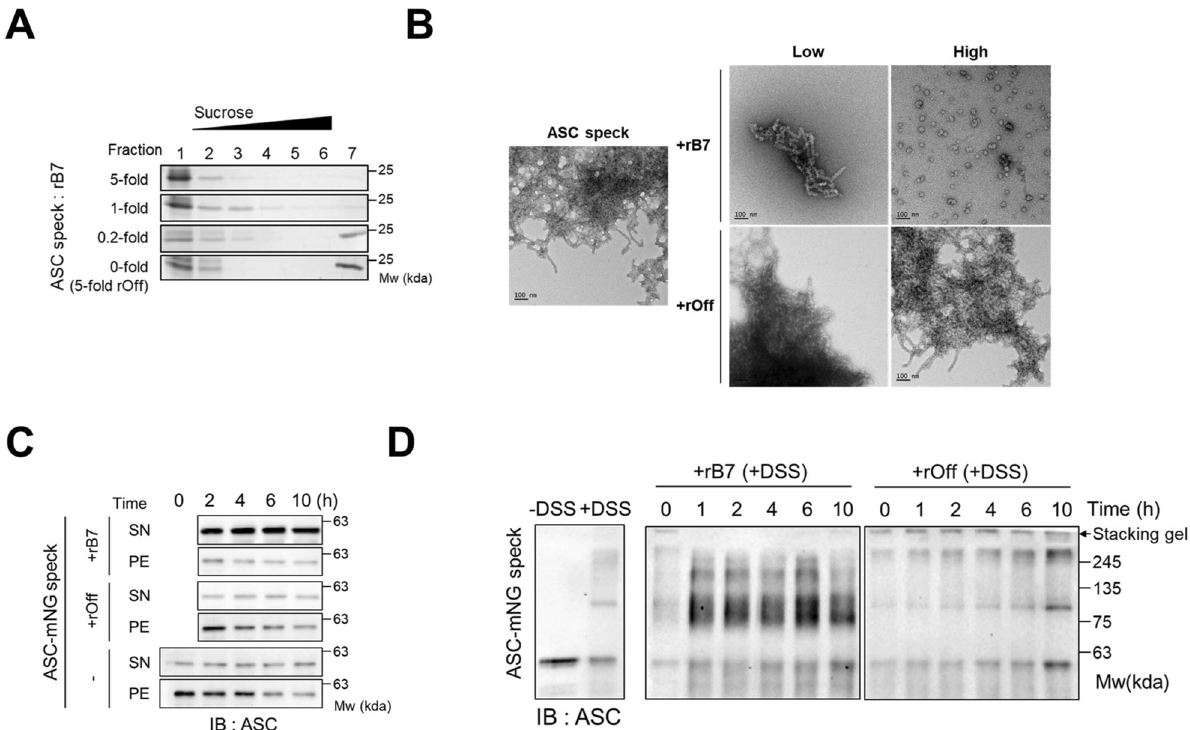
Fig. 2 The ASC PYD -speci fi c protein binder effectively disassembles preformed ASC specks. A The ASC levels in each fraction were obtained through sucrose-gradient (5 – 45%) ultracentrifugation of recombinant ASC specks. ASC specks were prepared by TEV cleavage of 5 μ M MBP- fused full-length ASC, followed by the addition of rB7 as designated molar ratio for 1 h and ultracentrifugation (42,000× g , 10 min). rOff indicates off-target protein binder (wild-type repebody). B Negative stain EM images of recombinant ASC specks after treatment with rB7 or rOff. ASC specks are prepared by the same method as in ( A ). Low (15 μ g/ml) and high (50 μ g/ml) concentrations of rB7 or rOff were added to 30 μ g/ml of preformed ASC specks for 30 min. Bars indicate 100 nm. C Changes in the levels of mNeonGreen-fused ASC specks in the supernatants (SN) and pellet (PE) after centrifugation (18,000× g , 20 min) over time. mNeonGreen-fused ASC specks were expressed and puri fi ed from HEK293 cells. ASC speck particles were diluted to ~5 × 10 5 per μ l in DPBS, followed by incubation with 10 μ M of rB7 or rOff, and the relative amounts of ASC in the supernatants and pellet were analyzed through a western blot. Treatment of ASC specks with DPBS was used as the negative control. Data were representative of three independent experiments. D . Western blot analysis of cross-linked mNeonGreen-fused ASC specks after incubation with 10 μ M of rB7 or rOff. Samples obtained at designated time intervals were cross-linked by 2 mM DSS for 30 min. Data were representative of three independent